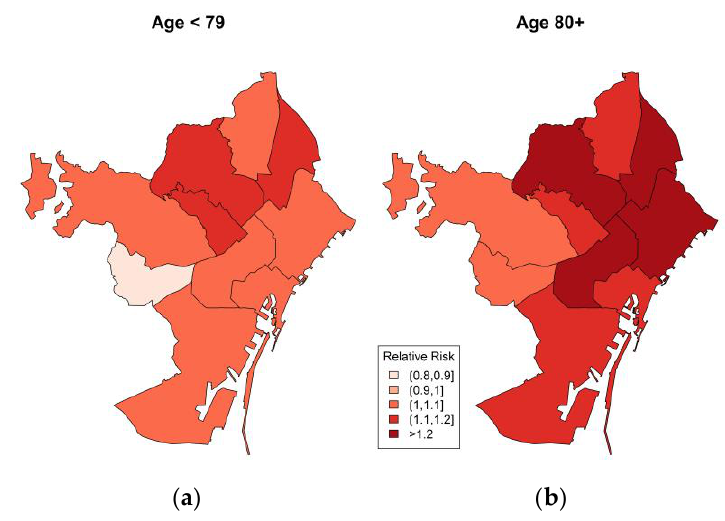
Figure 2. Relative risk of all-cause mortality related to summer extreme temperatures by district during the study period 1992–2015 in Barcelona in ( a ) age group less than 79 and ( b ) age group 80 and older.